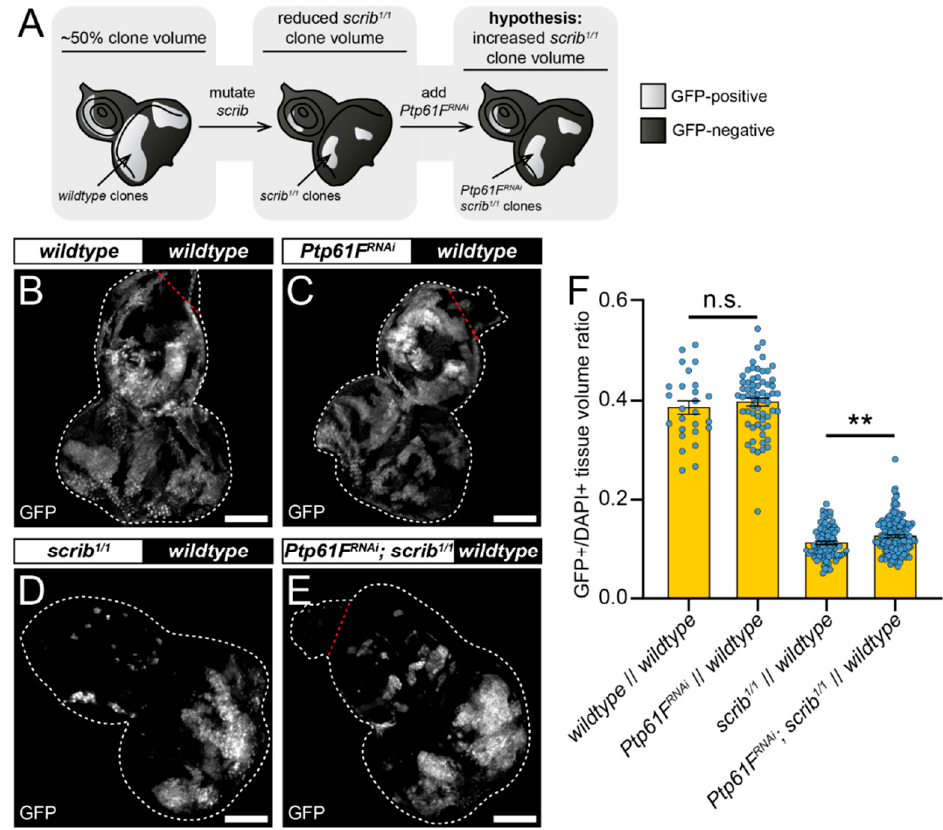
Figure 2. Ptp61F contributes to scrib -mutant clone elimination. ( A ) Diagram of our experimental process and hypothesis. ( B – E ) Confocal images of L3 eye-antennal imaginal discs of the indicated genotypes (boxes at top, white indicates GFP-positive clones, black indicates remaining GFP-negative tissue) taken from animals where clones were generated via MARCM to express transgenes in scrib -mutant, GFP-positive cells. ( B , C ) When GFP-positive tissue is wild-type ( B ) it makes up ~40% of the tissue ( n = 26, 𝑥̅ = 0.386 ± 0.013), and Ptp61F RNAi expression ( C ) does not significantly alter the contribution of the clones to the tissue ( n = 64, 𝑥̅ = 0.397 ± 0.008) (Student’s t -test, d.f. = 88, t = 0.7263, p > 0.05). ( D , E ) scrib -mutant clones ( D ) make up only ~11% of the tissue ( n = 88, 𝑥̅ = 0.113 ± 0.003), but Ptp61F RNAi expressed in scrib -mutant clones ( E ) leads to a small, but statistically significant increase in clonal volume to ~13% ( n = 144, 𝑥̅ = 0.127 ± 0.003) (Student’s t -test, d.f. = 230, t = 2.829, p < 0.01). ( F ) Quantification of the clone tissue volume contributions, as measured by the ratio of GFP-positive tissue to DAPI-positive tissue, showing that Ptp61F knockdown significantly increases the size of scrib -mutant clones. Note that Dcr-2 is also expressed wherever GFP is expressed. ** = p < 0.01. Error bars = S.E.M. Confocal microscopy images are maximum intensity projections. White dotted lines outline the tissue, red dotted lines indicate tissue excluded from quantification for consistency. Scale bars = 100 μ m.